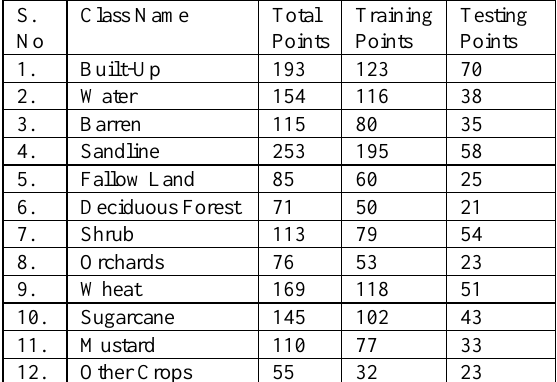
Figure 3. Methodology Adopted in Study Table 2: No of Points used in Training and Testing of classifier for different